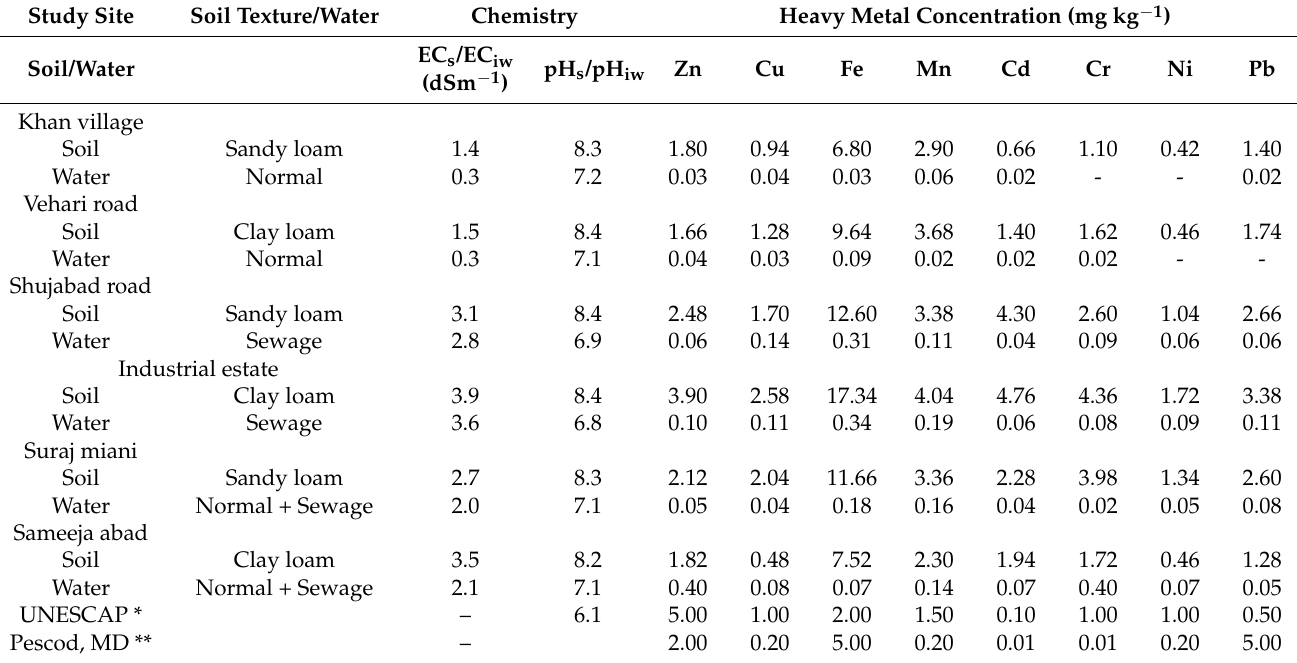
Table 1. Chemistry (EC and pH) and concentrations of the heavy metals in the study soils and their irrigation wastewaters, sampled during 2015–2016 from six major vegetable production areas in the Multan region of Pakistan